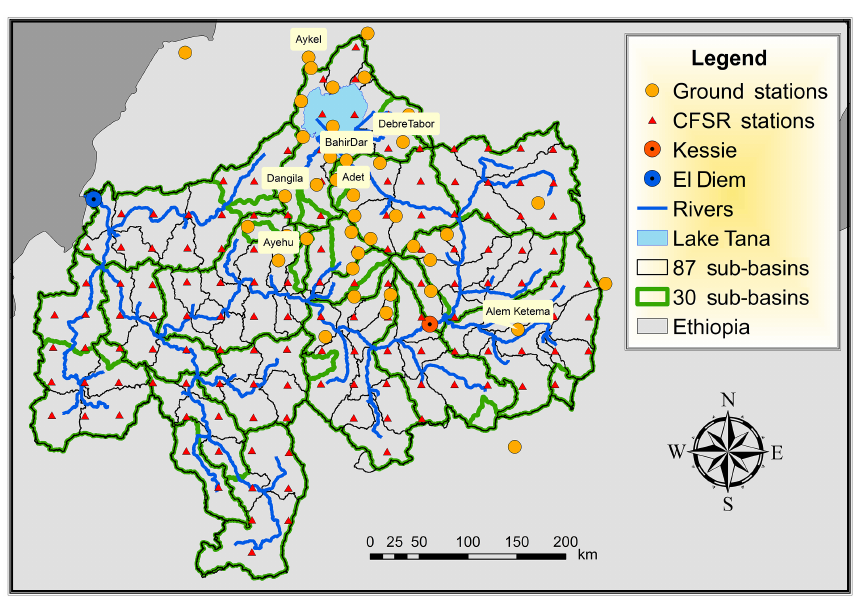
Figure 3. Weather and hydrometric gauging stations in the upper Blue Nile Basin under two discretization levels of 30 and 87 sub-basins (SWAT30 and